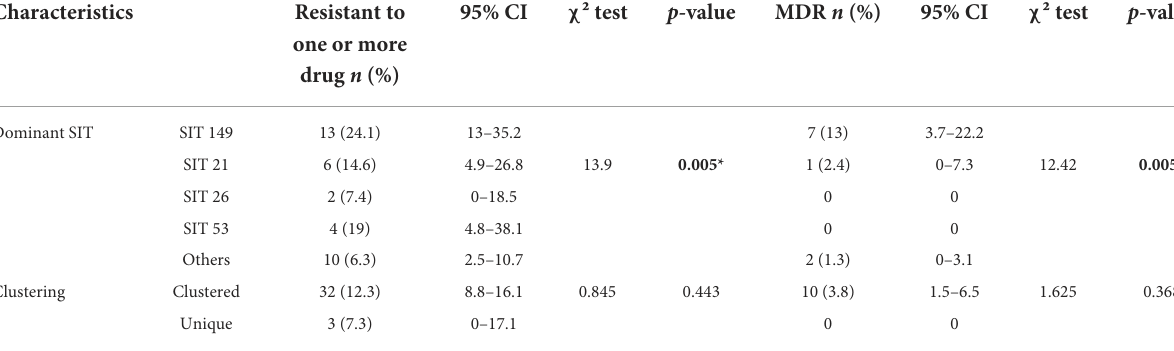
TABLE 3 Genotype of Mycobacterium tuberculosis and its association with drug resistance in the Somali region, Ethiopia ( n = 302).